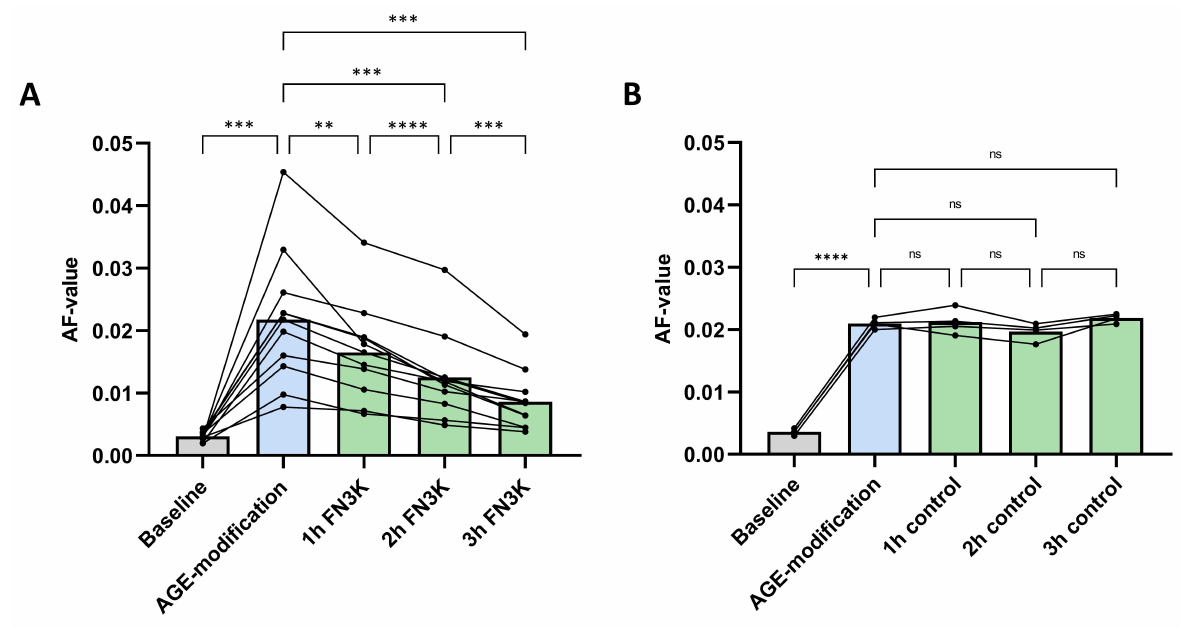
Figure 4. ( A ) Autofluorescence (AF) values of glycolaldehyde-induced advanced glycation end product (AGE)-modified porcine lens fragments after fructosamine-3-kinase (FN3K, n = 11) and ( B ) control ( n = 4) treatment with the cofactors ATP and MgCl 2 solely. The bars represent the mean. **** p < 0.0001; *** p < 0.001; ** p < 0.01; ns,